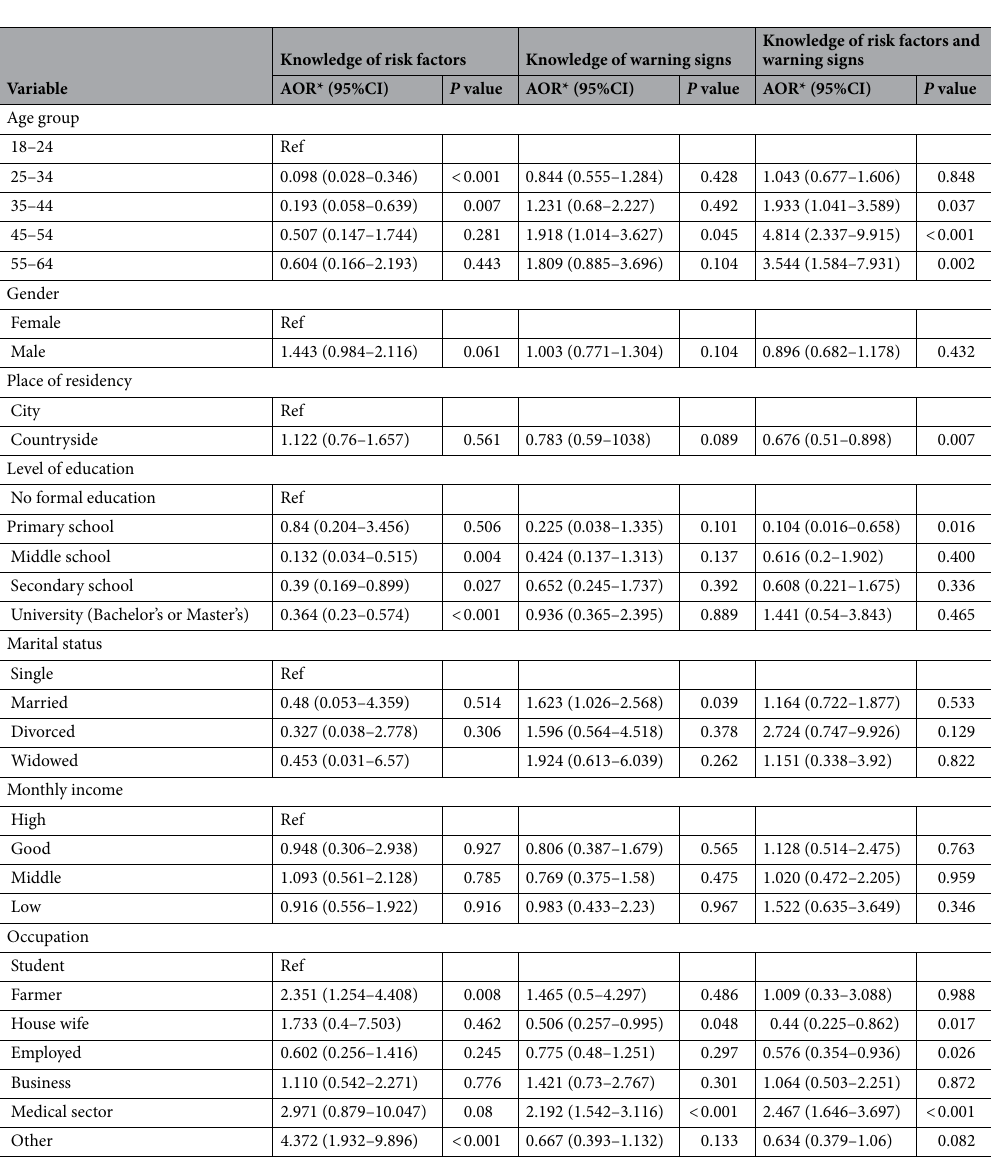
Table 5. Predictors of adequate knowledge of risk factors and warning signs. *AOR: Adjusted odds ratio, which the performed logistic regression model included all